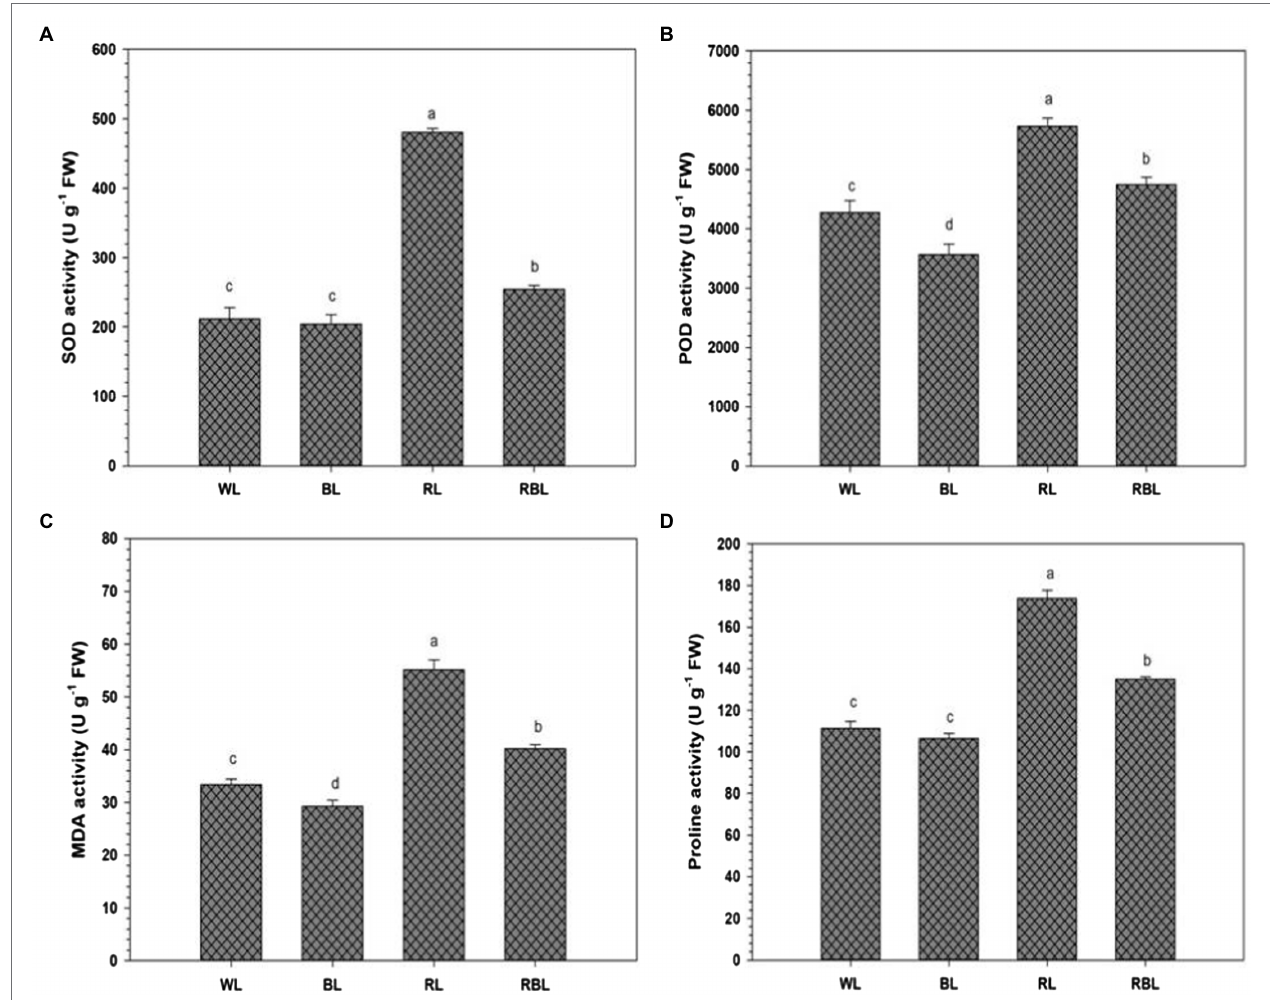
FIGURE 3 | Effects of differential light quality on superoxide dismutase (SOD) activity (A) , peroxidase (POD) activity (B) , malondialdehyde (MDA) content (C) , and proline content (D) in the leaves of industrial hemp grown under different color light-emitting diodes. Bars indicated the mean ± SD ( n = 3). Different letters on bars indicated significant difference between treatments at p ≤ 0.05. Different abbreviations used in the figure are as follows: WL, white light LED (control); BL, blue light LED, RL, red light LED; RBL, 50% red and 50% blue Light